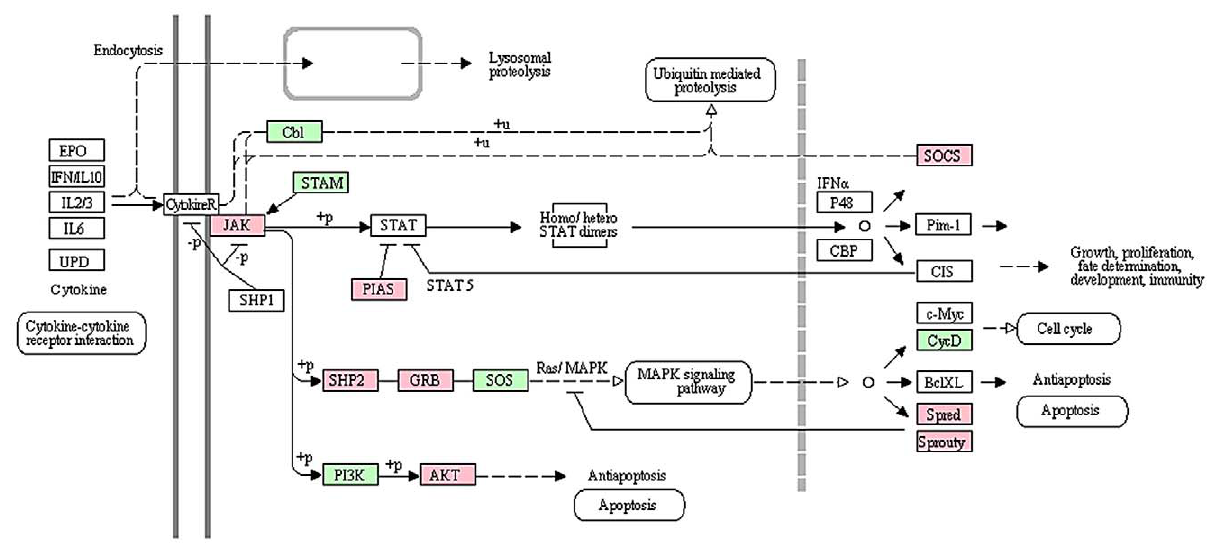
Figure 4. Relative abundance of different signal transducing genes responsive to dengue infection in Aedesaegypti . The percentage below each category represents the percentage of genes of that category with respect to all responsive genes related to signal transduction (based